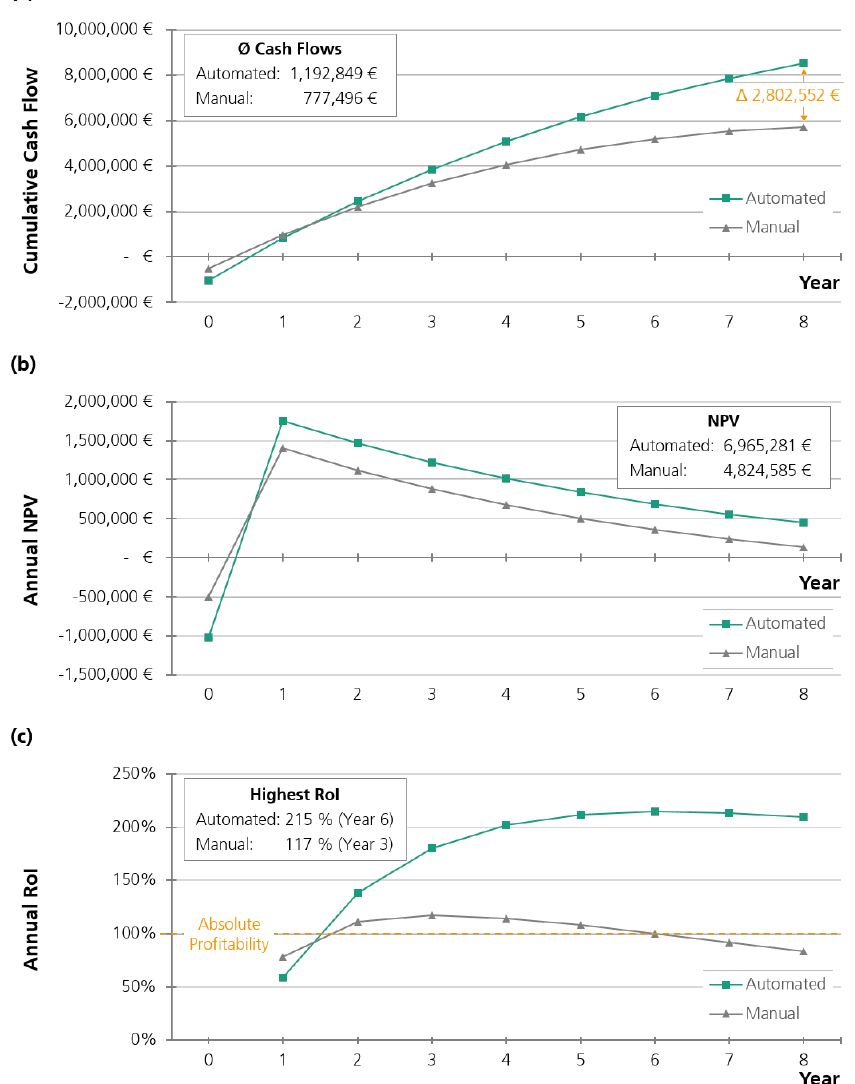
Figure 4. Economic analysis of automated and manual iPSC production for a machine lifetime of 8 years.